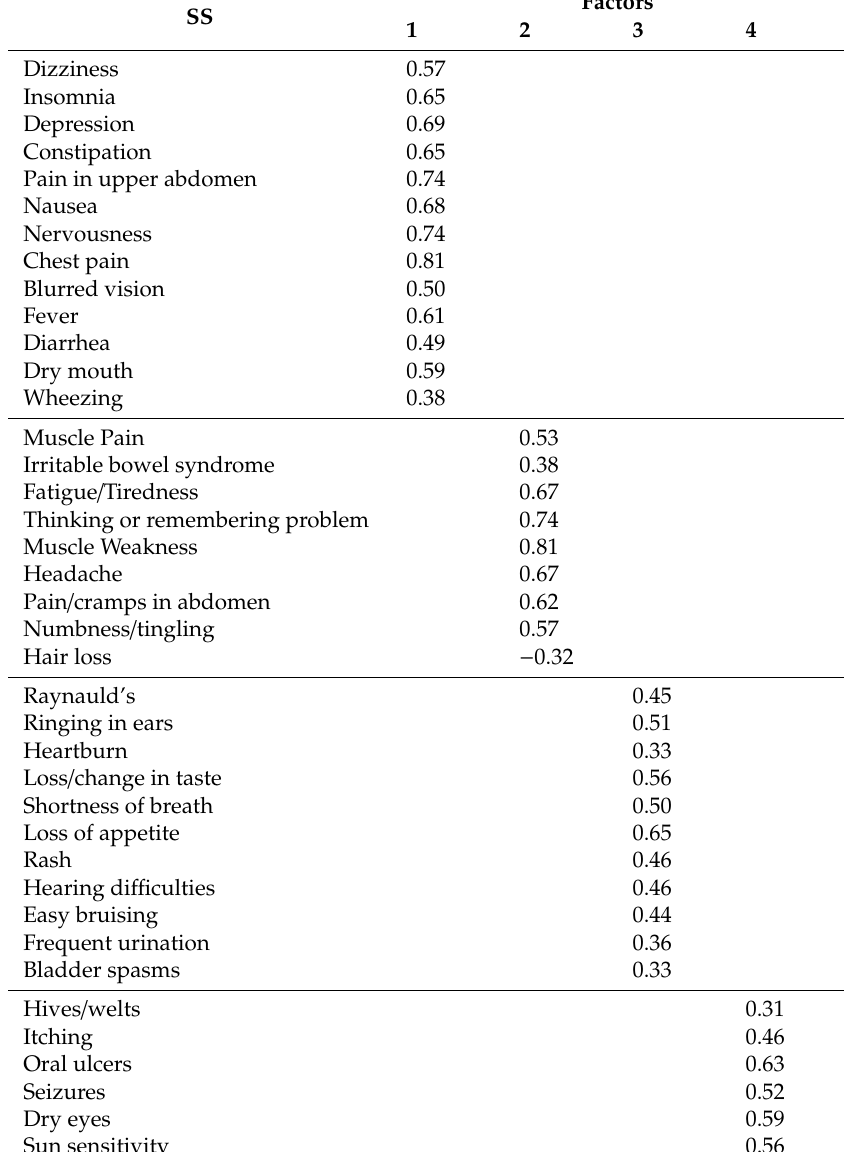
Table 3. Factor load matrix for CFA of Symptom Severity (SS) scale (Varimax